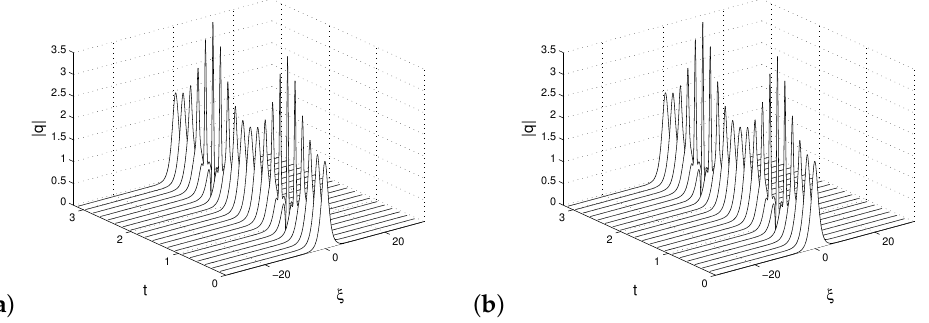
Figure 8. DMD reconstructions, based on new observable g 1 defined by (31). Reconstruction by Algorithm 1 in ( a ) and by Algorithm 2 in ( b ).